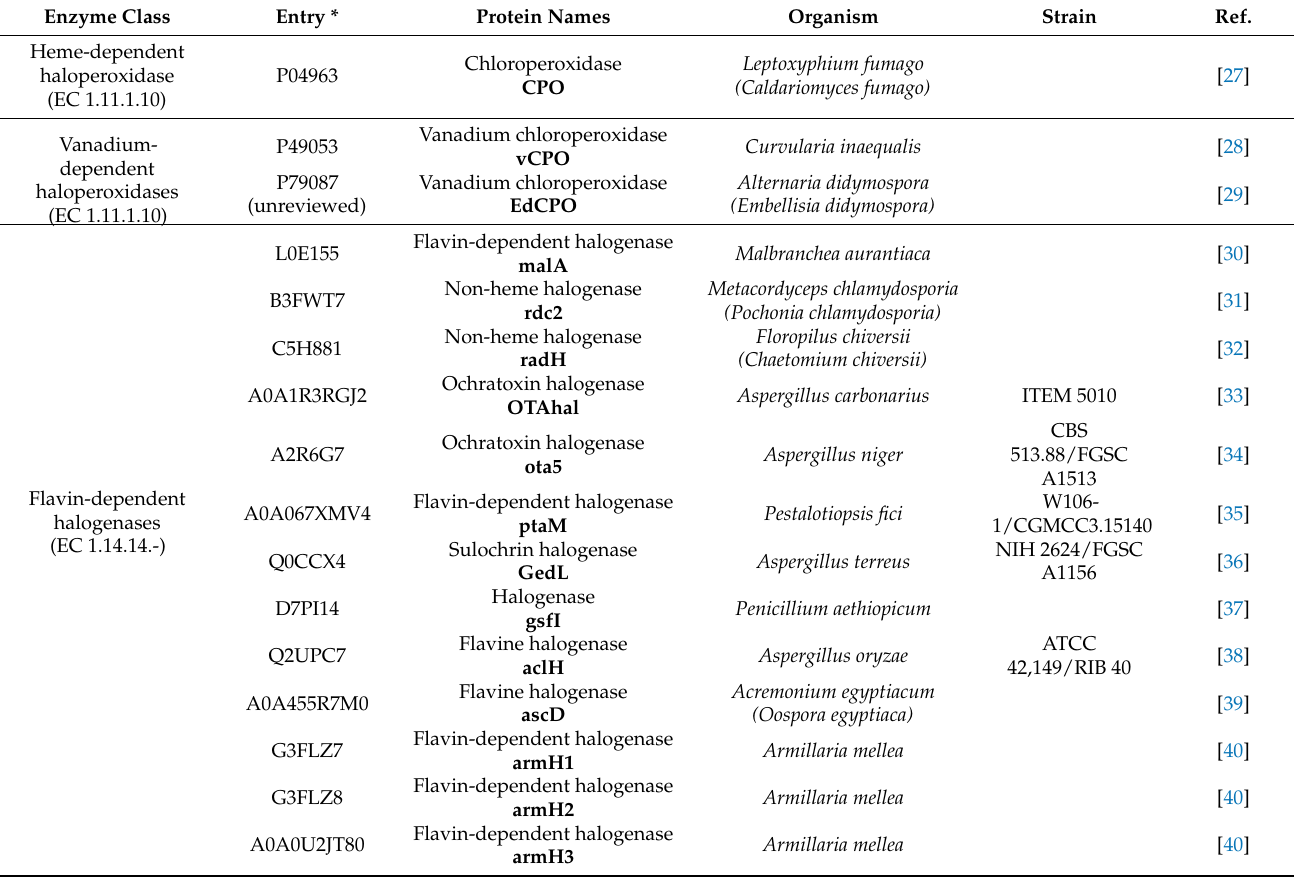
Table 1. Halogenation enzymes characterized in fungi in